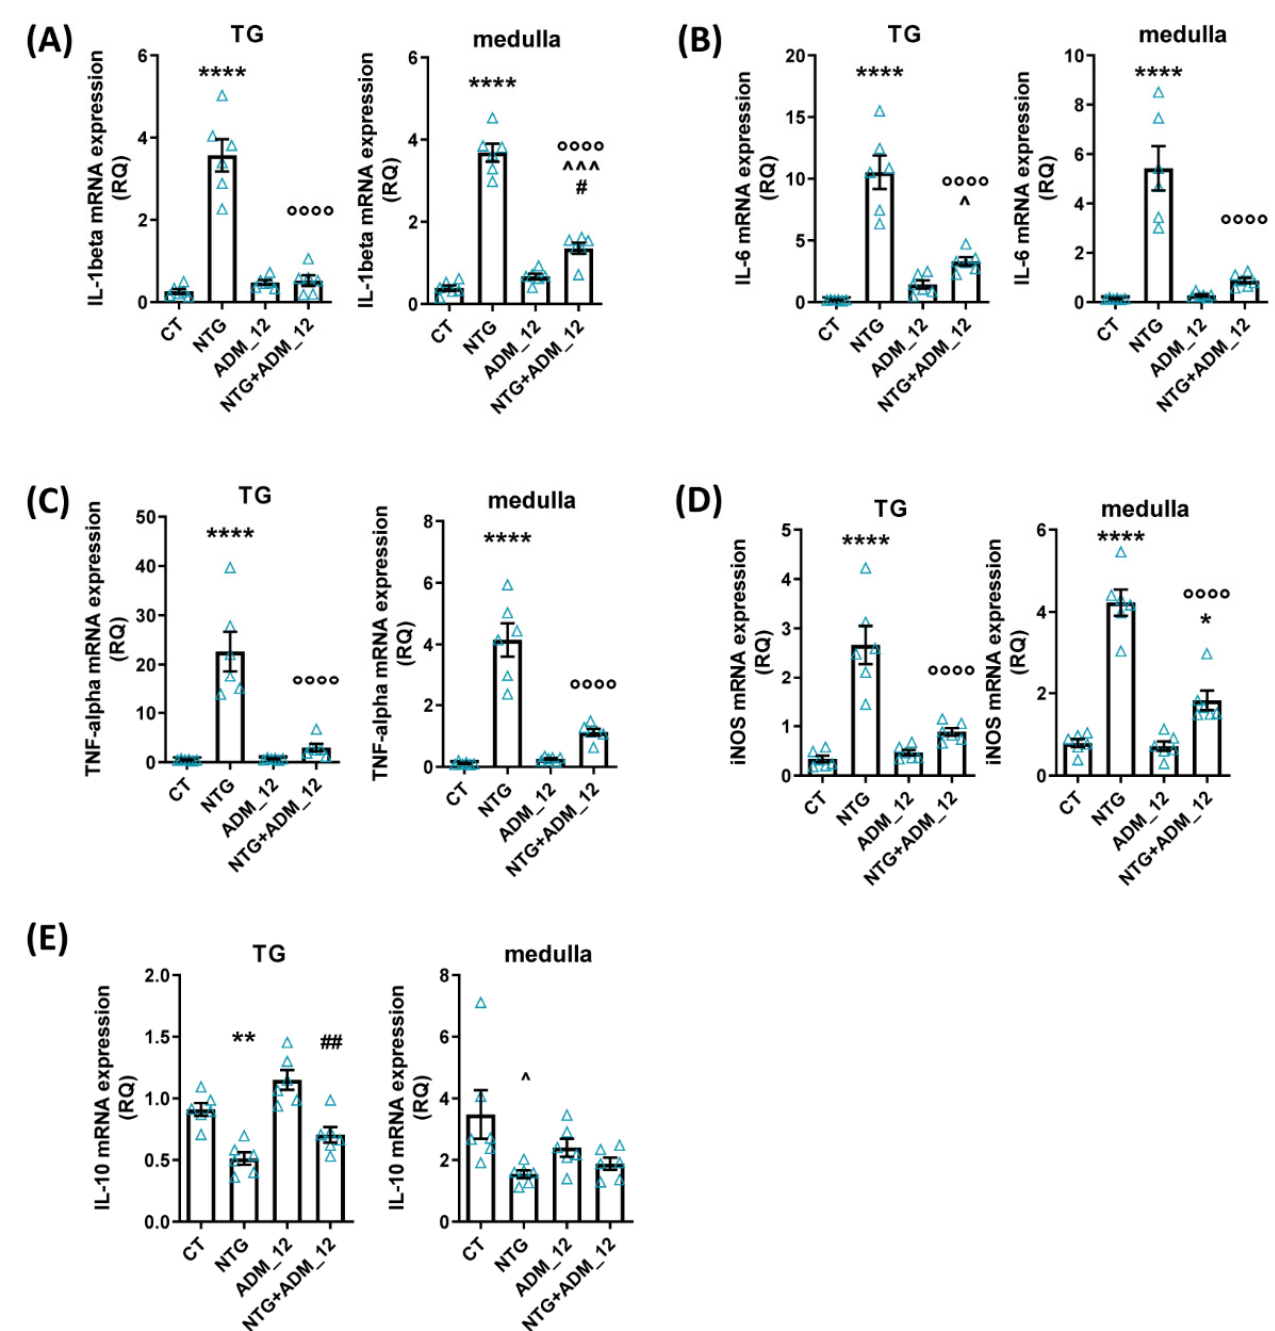
Figure 6. Effects of ADM_12 (30 mg/kg) on the gene expression of pro- and anti-inflammatory cytokine mediator gene expression in the Medulla oblongata and following the TG ipsilateral to formalin injection. ( A ) IL-1beta, ( B ) IL-6, ( C ) TNF-alpha, ( D ) iNOS, ( E ) IL-10 mRNA levels (expressed as relative quantification, RQ; see Section 4 for details) in the acute migraine model ( n = 6 per group). CT: Control. * p < 0.05, ** p < 0.01 and **** p < 0.0001 vs. CT and ADM_12; ◦◦◦◦ p < 0.0001 vs. NTG; ˆ p < 0.05 and ˆˆˆ p < 0.01 vs. CT; # p < 0.05 and ## p < 0.01 vs. ADM_12. Data are expressed as the mean ± SEM; one way ANOVA followed by Tukey’s multiple comparisons